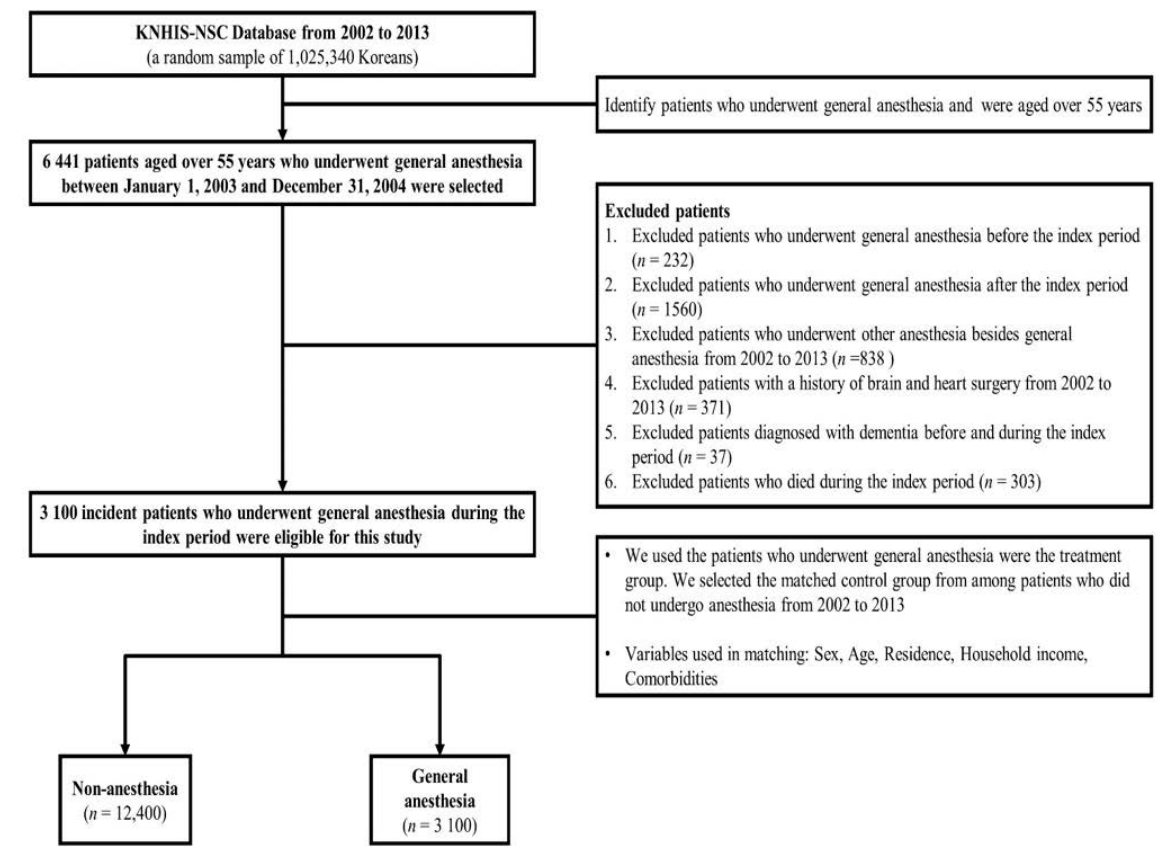
Figure 1. Schematic description of study’s